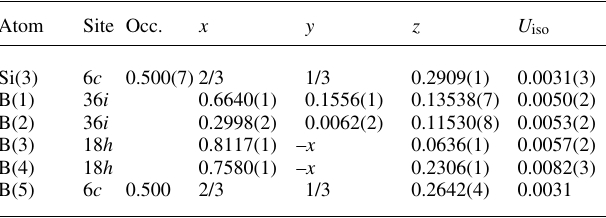
Table 2. Atomic coordinates and displacement parameters (in Å 2 )